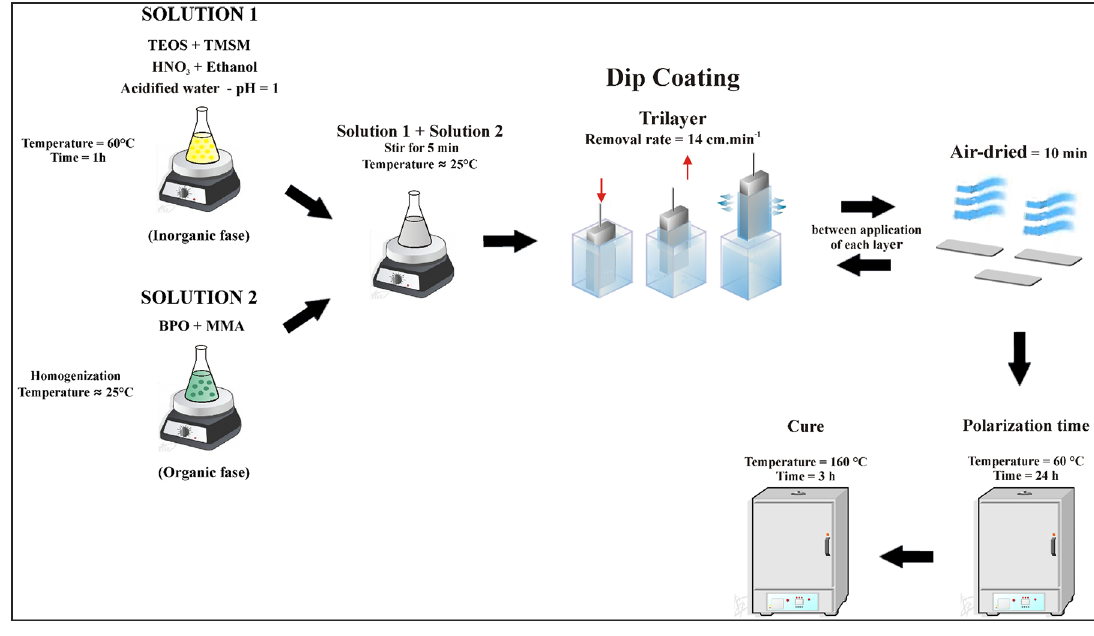
Figure 1. Schematic representation of the coating elaboration.